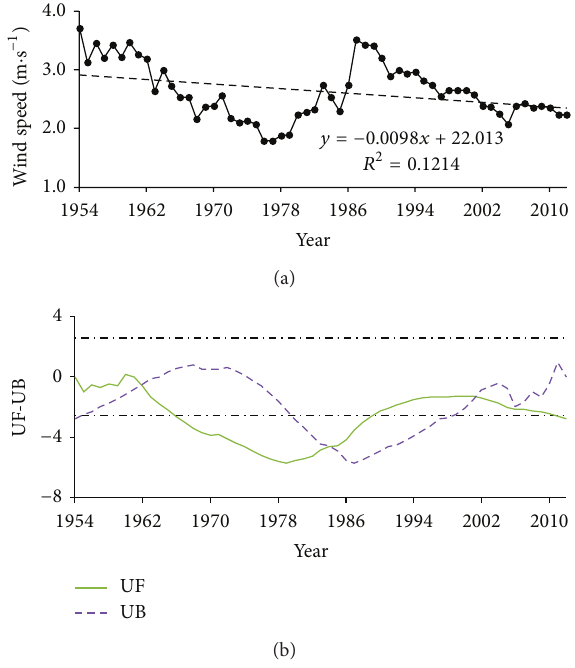
Figure 8: Temporal trend of the mean wind speed (a) and the trend results from the Mann-Kendall method